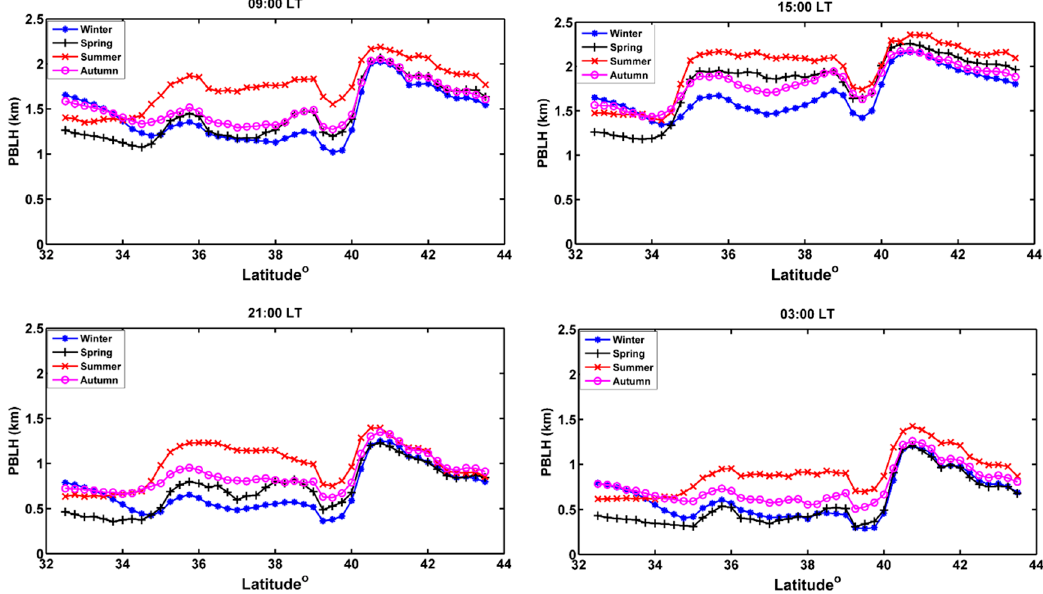
Figure 6. Latitudinal variation of average PBLH at 127.5 ◦ E longitude from 2008 to 2017 at 09:00, 15:00, 21:00, and 03:00 LT (local time).